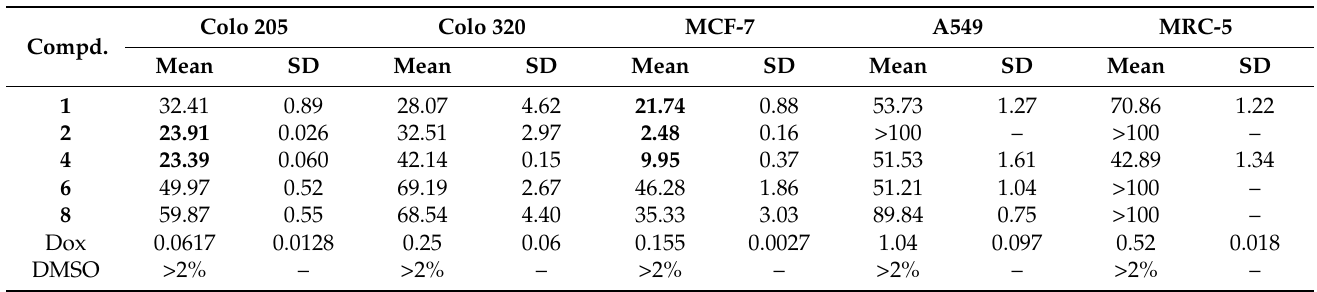
Table 3. Antiproliferative activity (IC 50 µ M) of pholiols L, M, O, Q, and S ( 1 , 2 , 4 , 6 , and 8 ) in human sensitive (Colo 205) and resistant (Colo 320) colon adenocarcinoma cells. and normal embryonal fibroblast (MRC-5) cell line.